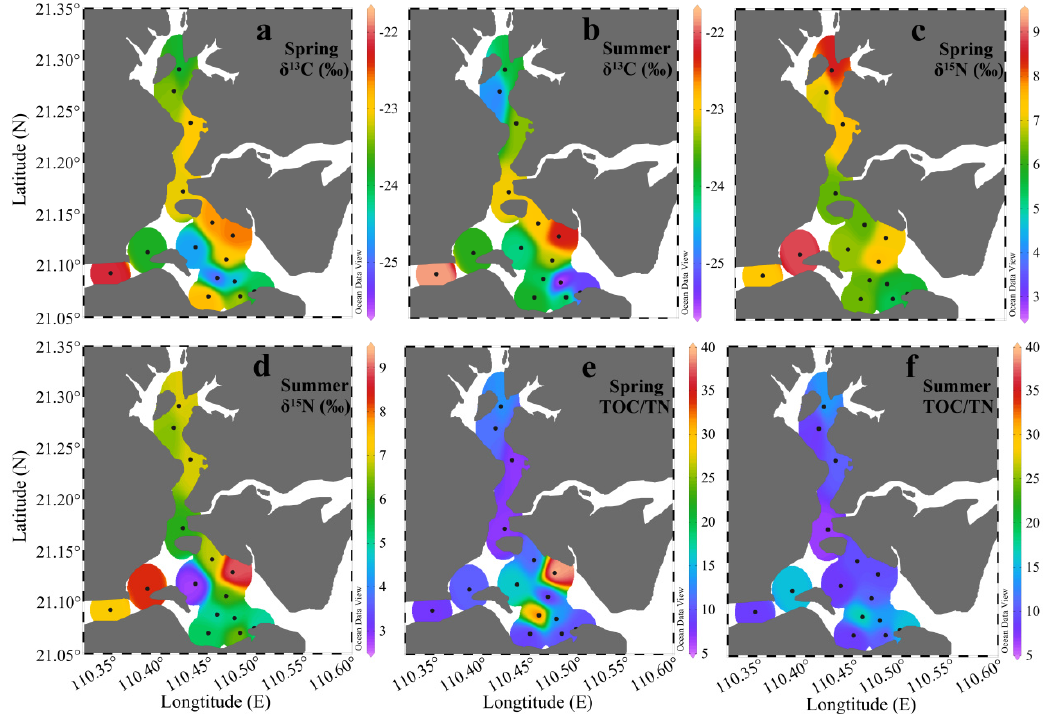
Figure 5. Distributions of δ 13 C ( a , b ), δ 15 N ( c , d ), and TOC / TN ( e , f ) in the surface sediments of Zhanjiang Bay in spring and summer.